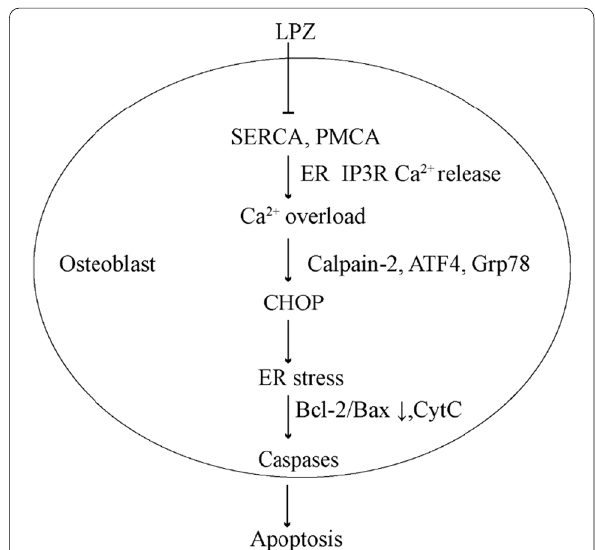
Fig. 14 Possible mechanisms underlying the changes in [Ca 2 + ]